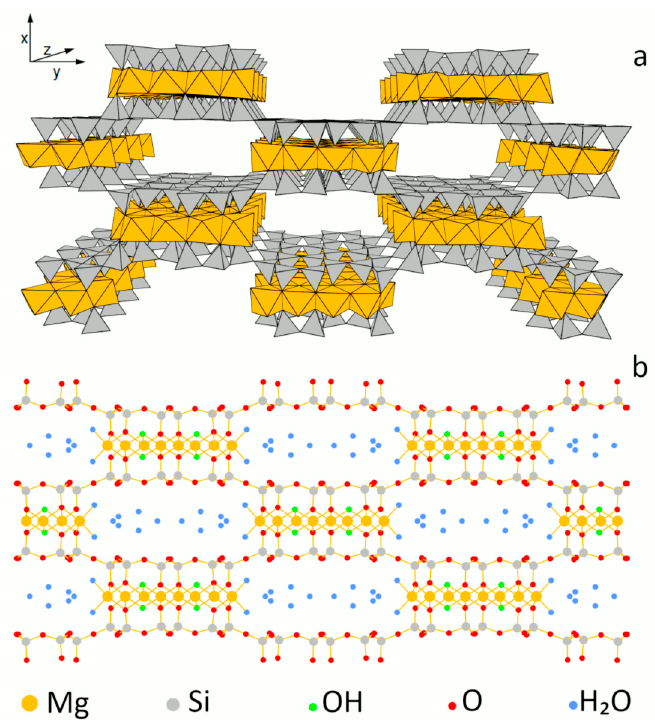
Figure 1. Model of sepiolite structure: ( a ) polyhedral, ( b ) ball and stick.